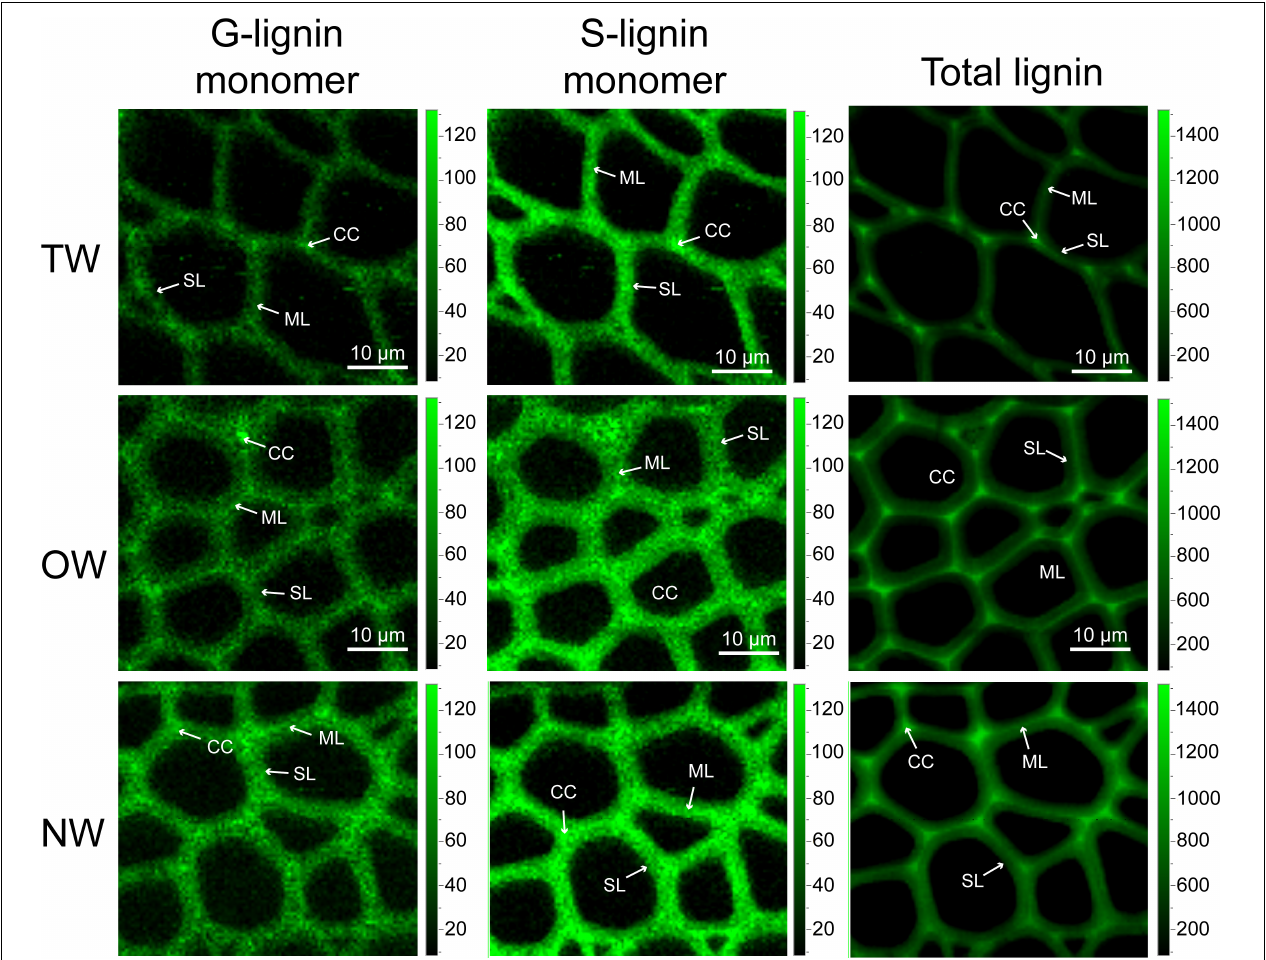
FIGURE 2 | Confocal Raman spectral imaging of tension wood (TW), opposite wood (OW), and normal wood (NW). Confocal Raman images of G-lignin monomer at 1,275 wavenumber/cm − 1 , S-lignin monomer at 1,337 wavenumber/cm − 1 , and total lignin at 1,607 wavenumber/cm − 1 . SL, secondary wall layer; ML, middle lamella; CC, cell